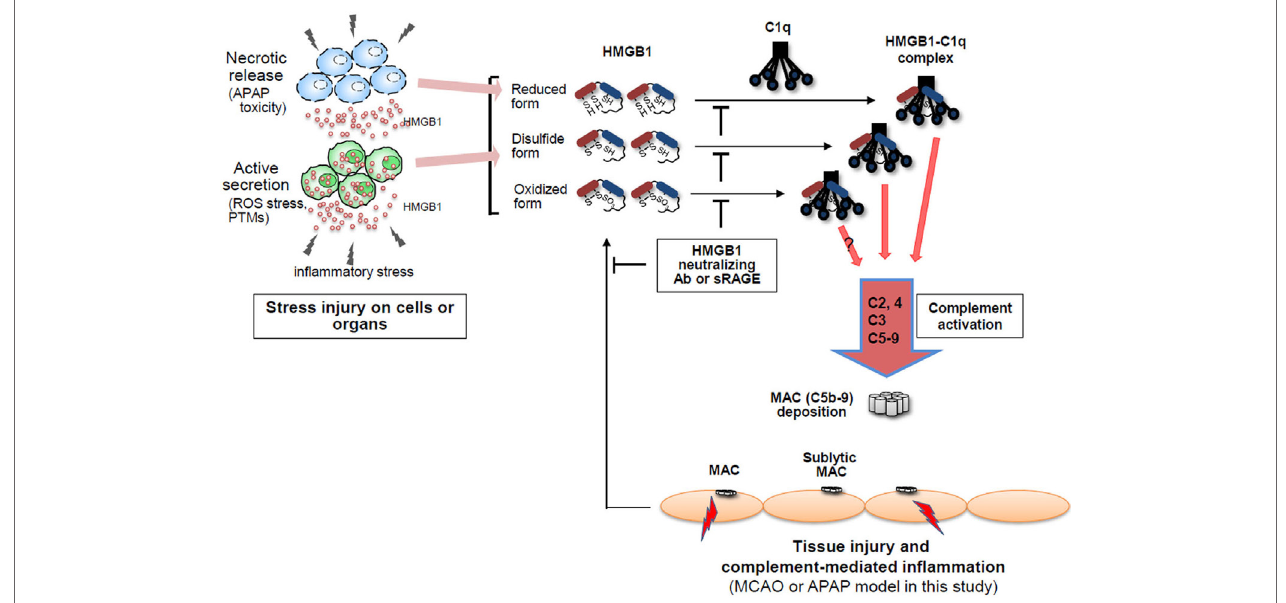
FigUre 7 | High-mobility group box 1 (HMGB1)-induced complement activation model. HMGB1 protein is actively secreted or passively released by stress injury on cells or organs in the forms of three different redox statuses, which may differently modulate immunological activities. Extracellular HMGB1 can activate the classical pathway of complement system in an antibody (Ab)-independent manner after binding to C1q, resulting in forming C5b-9 membrane attack complexes (MAC) where HMGB1 is accumulated. Thus, HMGB1-induced complement activation is proposed to be able to exacerbate sterile